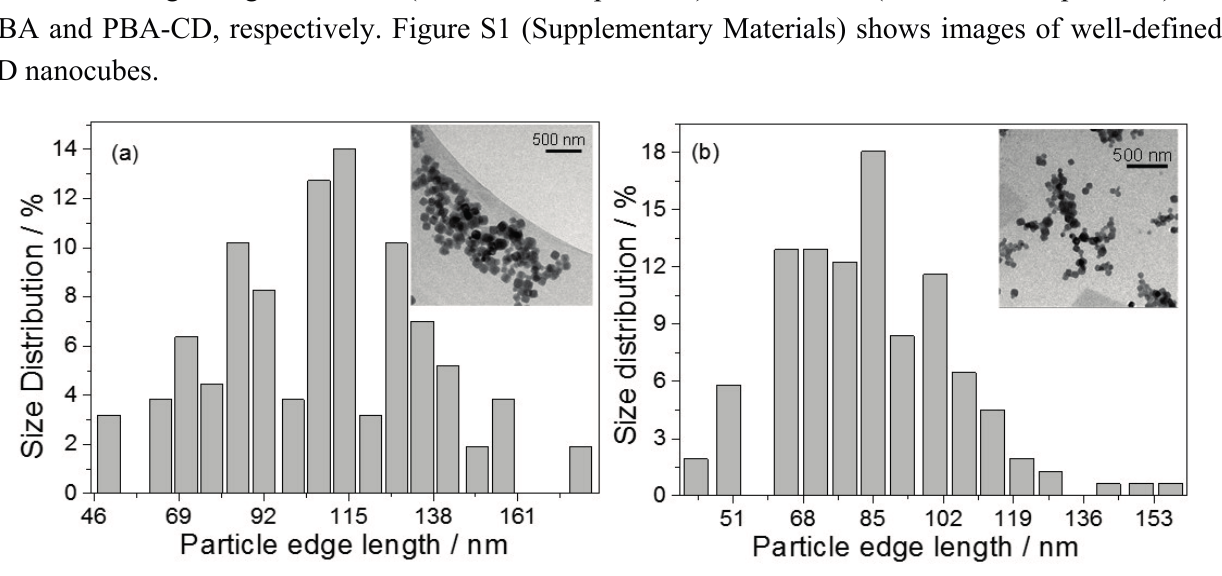
Figure 1. Size distribution histograms for ( a ) PBA and ( b ) PBA-CD nanocubes and corresponding TEM